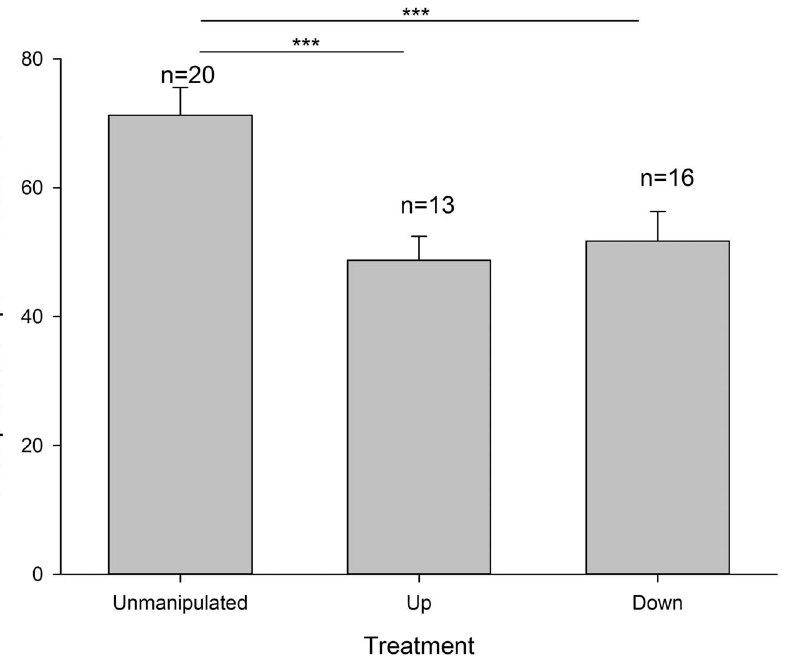
Figure 3. Comparisons in seed production per inflorescence among unmanipulated, UP, and DOWN inflorescences. Bars show standard errors. *** P , 0.001.